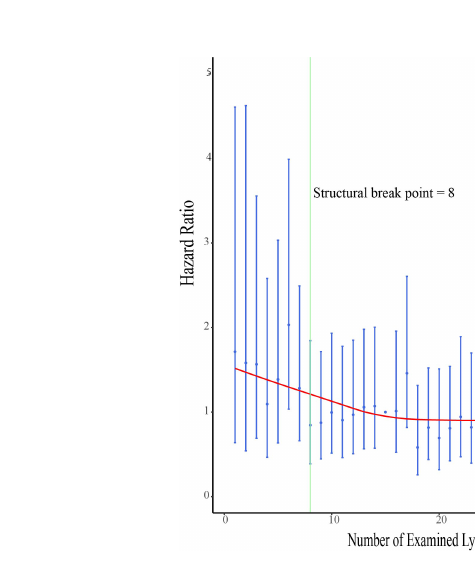
FIGURE 4 Association of examined lymph node (ELN) numbers with multivariable-adjusted hazard ratios (HRs) for overall survival. The adjusted HRs and the corresponding 95% con fi dence intervals are shown in blue, and the smoothed curves fi tted using the LOcally WEighted Scatterplot Smoothing (LOWESS) method with a default bandwidth of 2/3 are shown in red. The structural breakpoint determined by using ‘ strucchange ’ packages in R is shown in green.